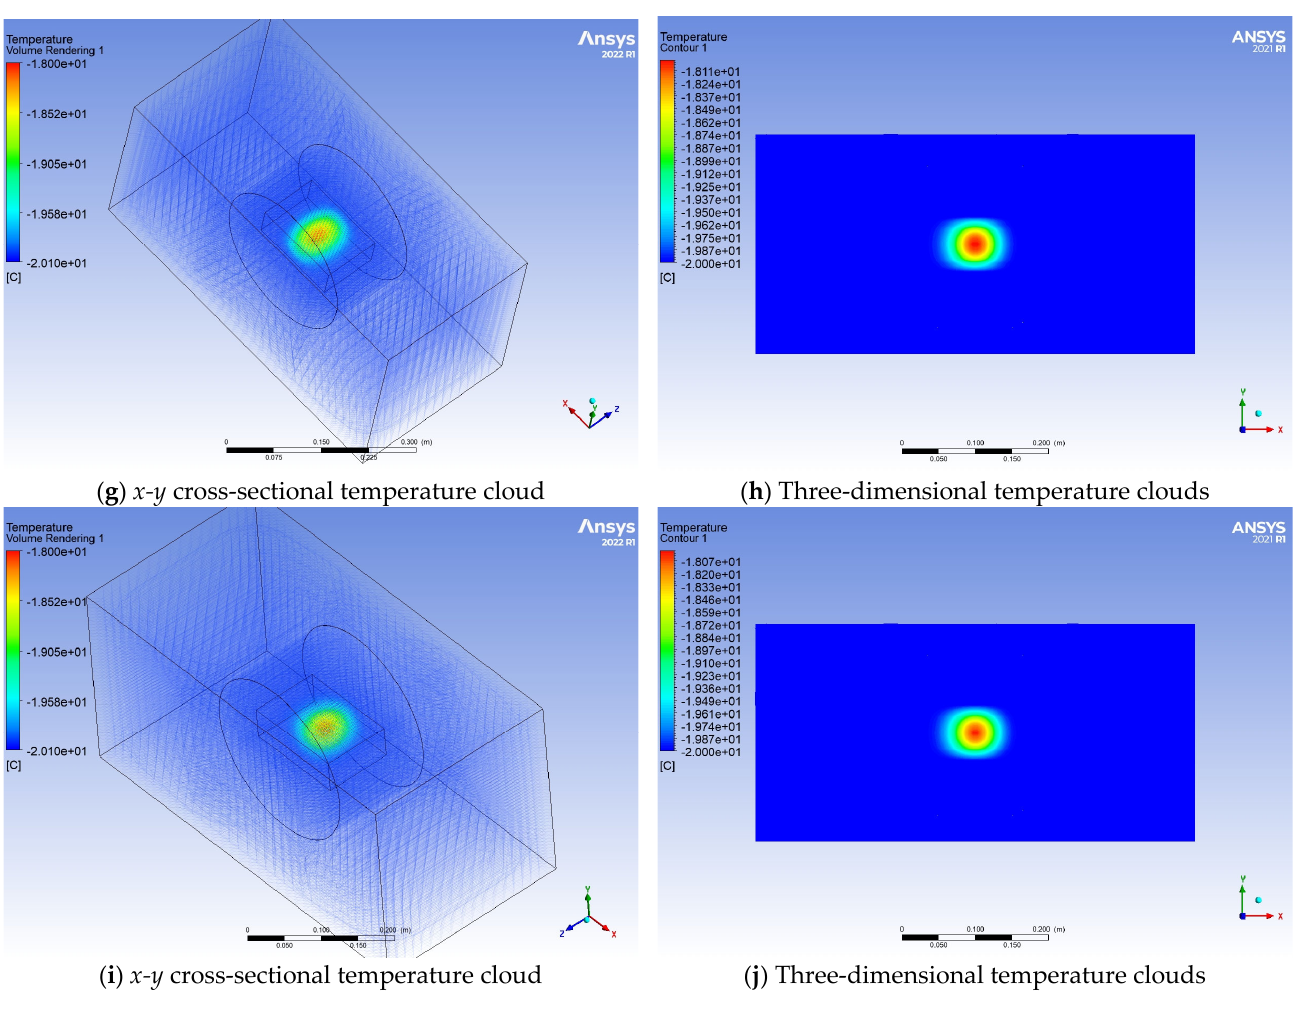
Figure 9. Temperature field program and x ‐ y section temperature program of the hopper at different speeds.